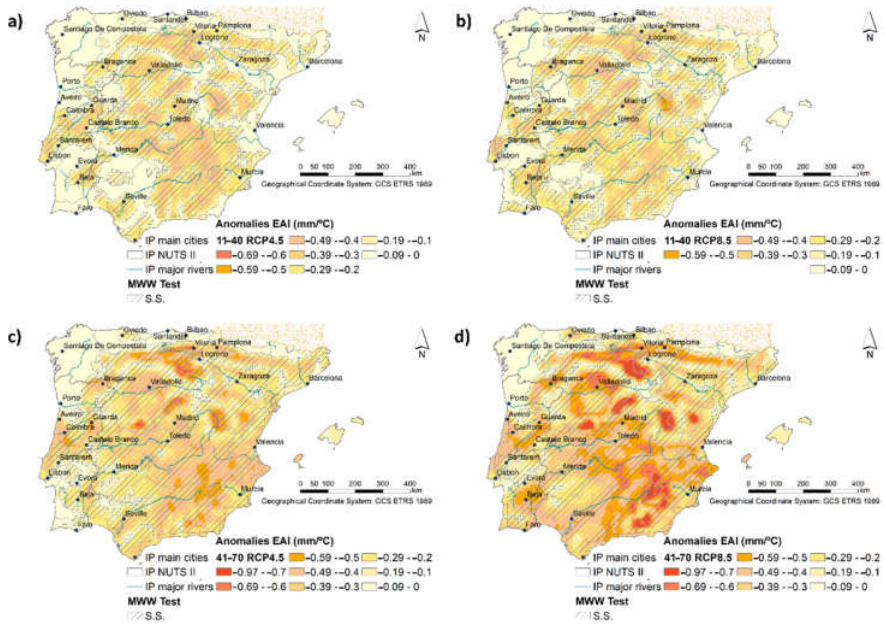
Figure 9. EAI anomalies (Mann–Whitney–Wilcoxon test at a 5% significance level) for the period ( a , b ) 2011–2040, ( c , d ) 2041–2070, with respect to the baseline climate (1961–1990), under RCP4.5 ( left ) and RCP8.5 ( right ).